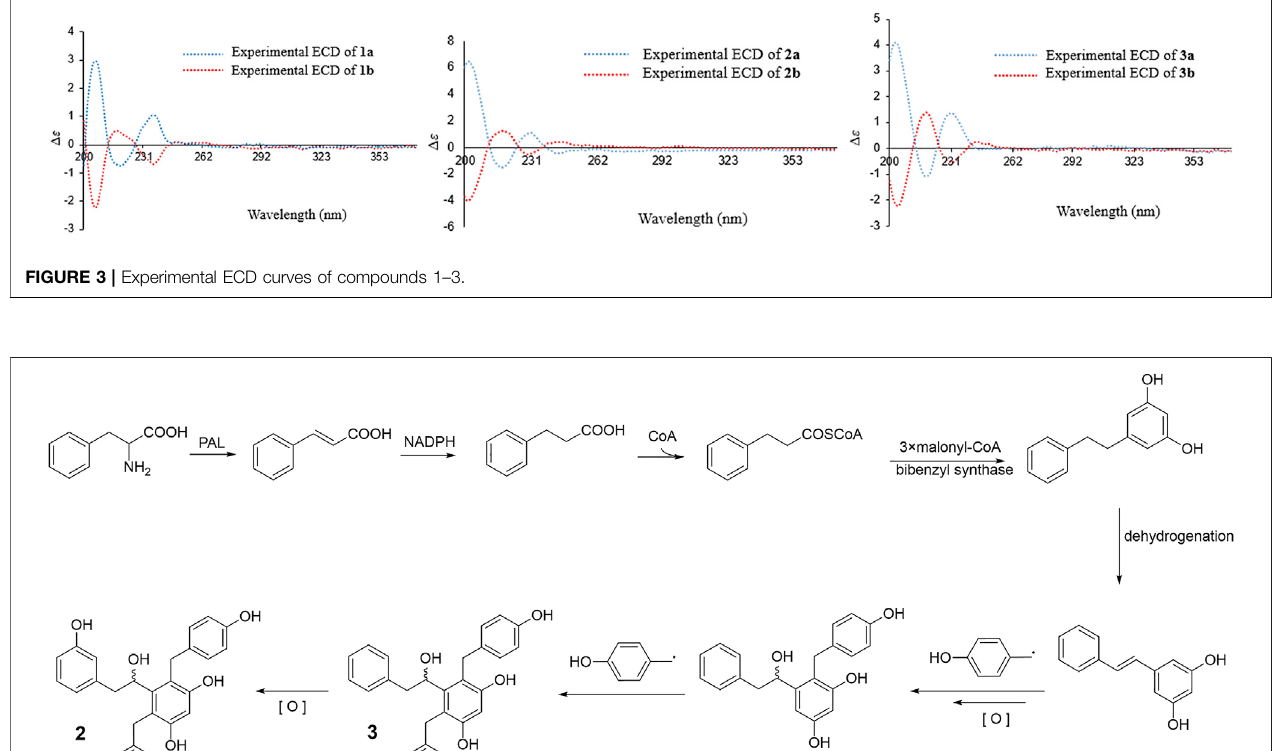
Frontiers in Chemistry |